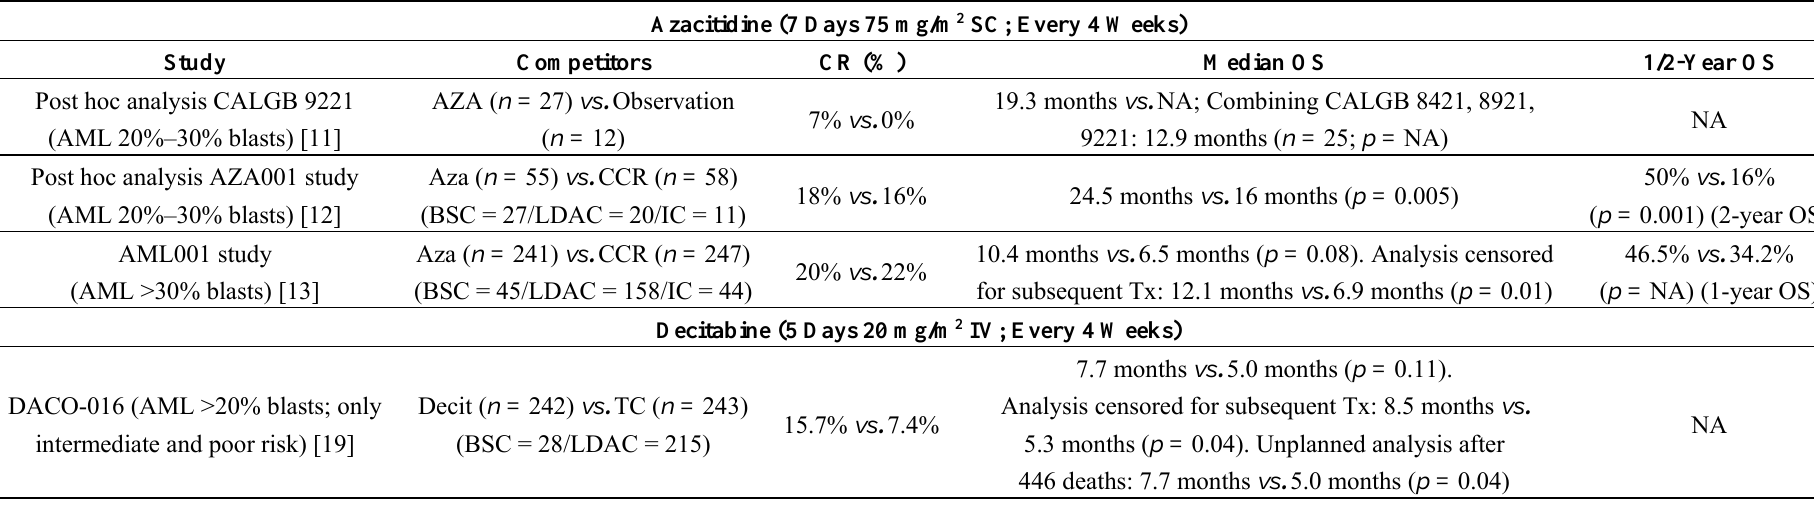
Table 1. Clinical outcome of phase 3 trials of azacitidine and decitabine in acute myeloid leukemia